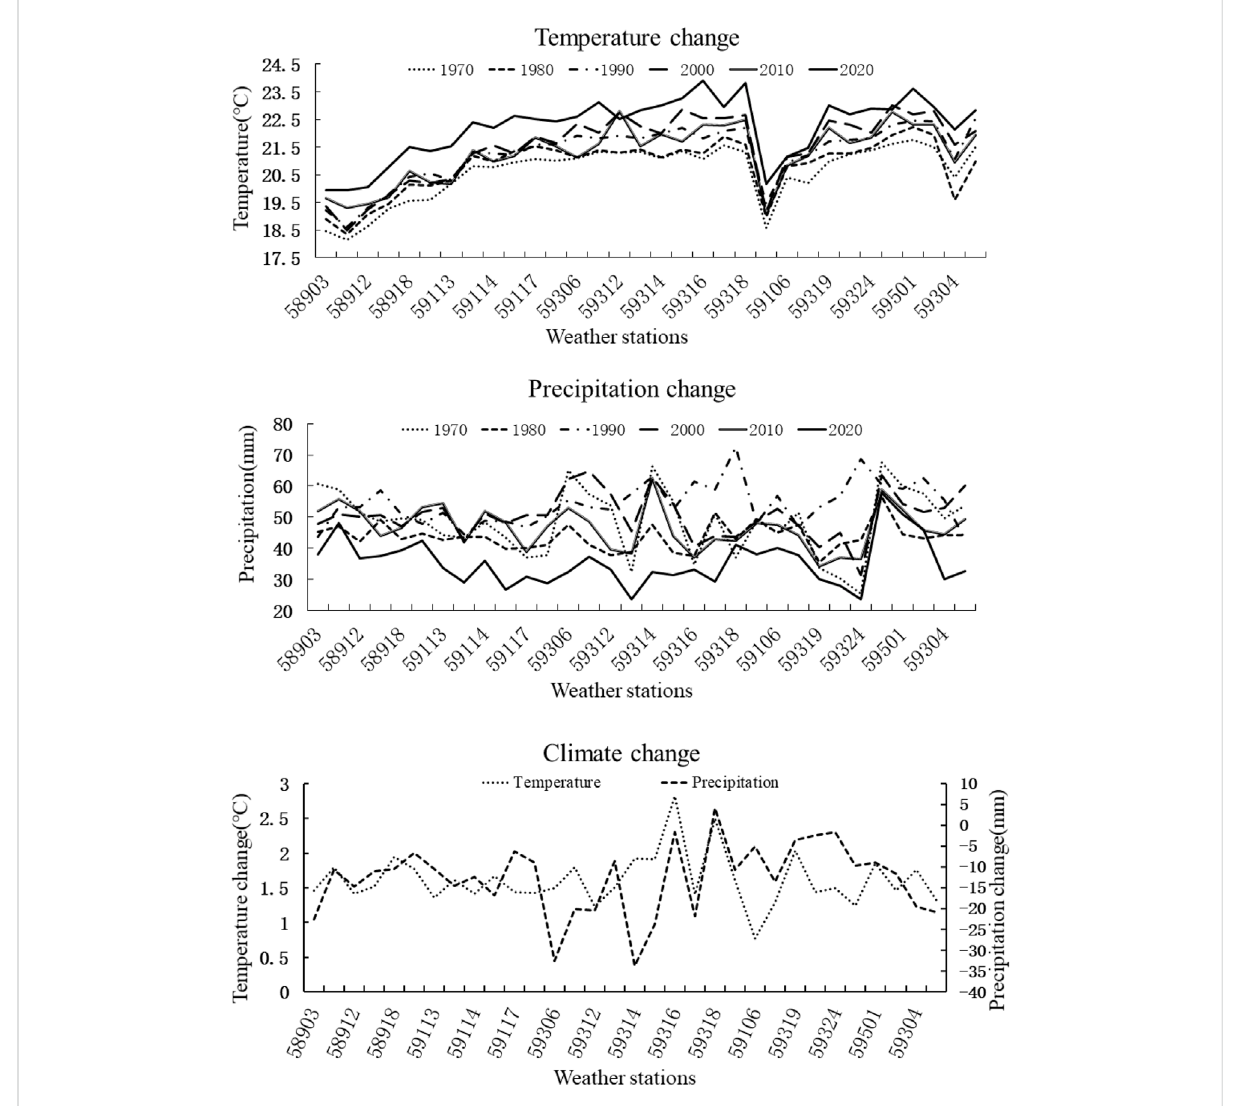
FIGURE 5 Climate change at meteorological stations in the Hanjiang River basin from 1970 to